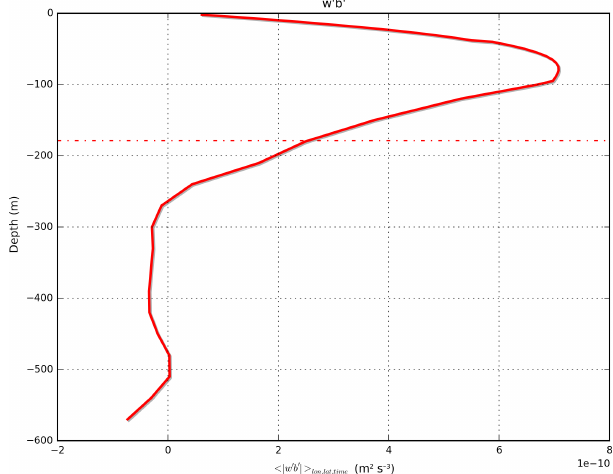
Figure 13. Vertical profile of w (cid:48) b (cid:48) averaged over the studied sub- domain (described in Fig. 9) during the winter season (January– February–March) in 2005. The dashed line represents the mixed layer depth averaged for the same period over the considered re-